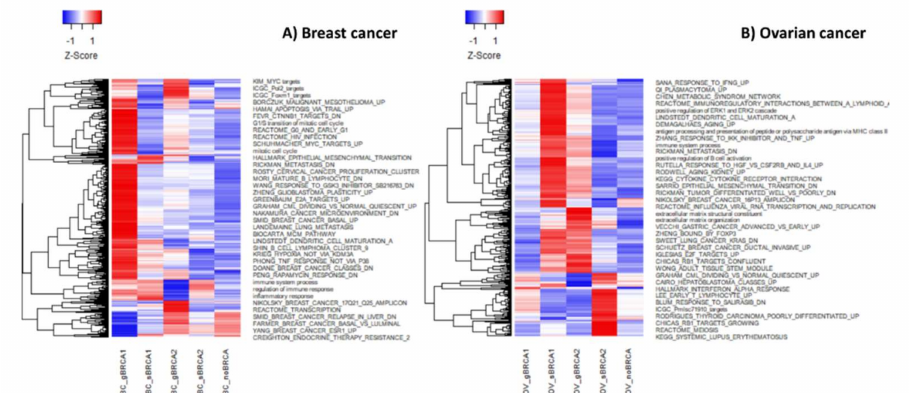
Figure 5. Clustering of deregulated BRCA1 - and BRCA2 -associated functional categories in the breast ( A ) and ovarian ( B ) cancers. One sees that the most prominent deregulations in breast cancer are linked to gBRCA1 in breast and sBRCA1/gBRCA2 in ovarian cancers, respectively. The gene sets upregulated in the gBRCA1 group include basal-phenotype signatures, immune/inflammatory response. In ovarian cancers, the upregulated functional categories are associated with immunity response (sBRCA1/gBRCA2) and chromosome/telomere maintenance (sBRCA2). More detailed clustering according to gene set types available in Supplementary Figures